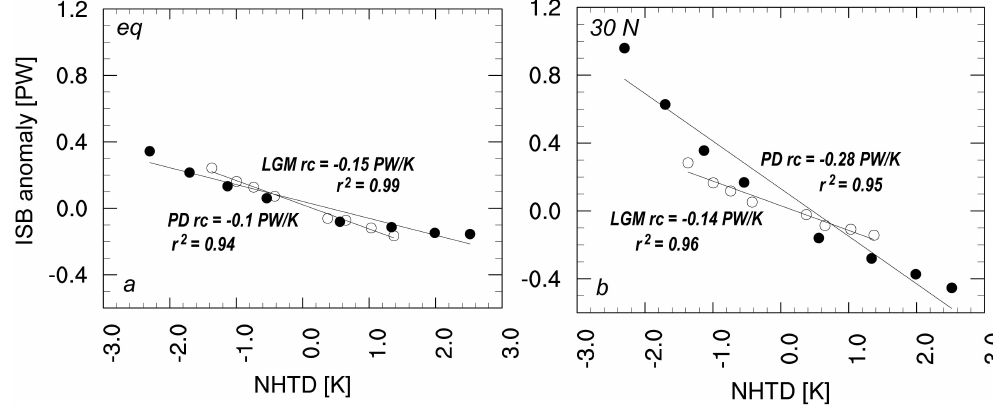
Fig. 10. Integrated surface budget anomalies (ISB), in PW, at the equator (a) and 30 ◦ N (b) for PD (full circles) and LGM (open circles) simulations as a function of NHTD anomaly (K). As in the Fig. 2, positive NHTD anomalies indicate NH cooling and vice versa. Linear regression coefficients and r 2 values of the fit are